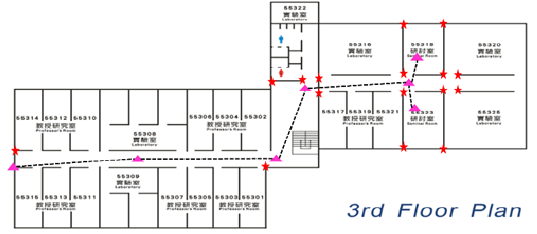
Figure 5. The sketch of indoor control points and check points